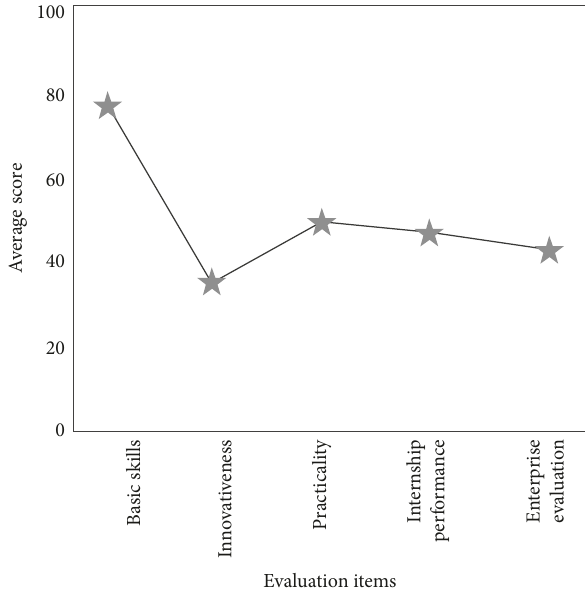
Figure 5: Results of optimizing the effectiveness of higher vocational business English teaching. Table 1: Comparison results of evaluation